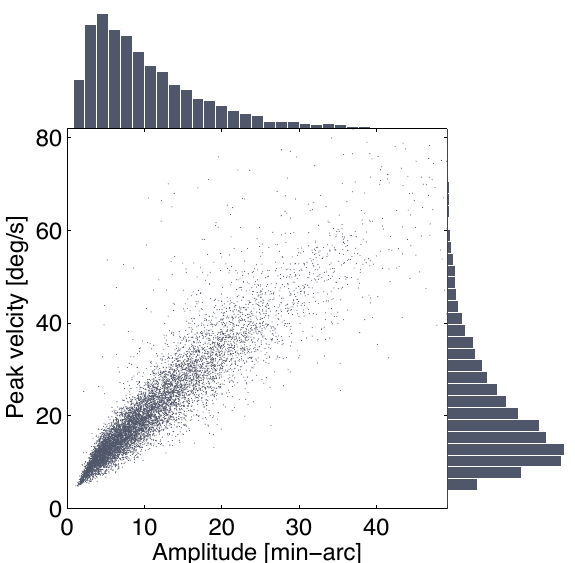
Figure 3 . Main sequence for microsaccades observed in the interval between 100 ms before target onset and the response saccade. Distributions of microsaccade amplitude and peak velocity are shown in the flanking bar